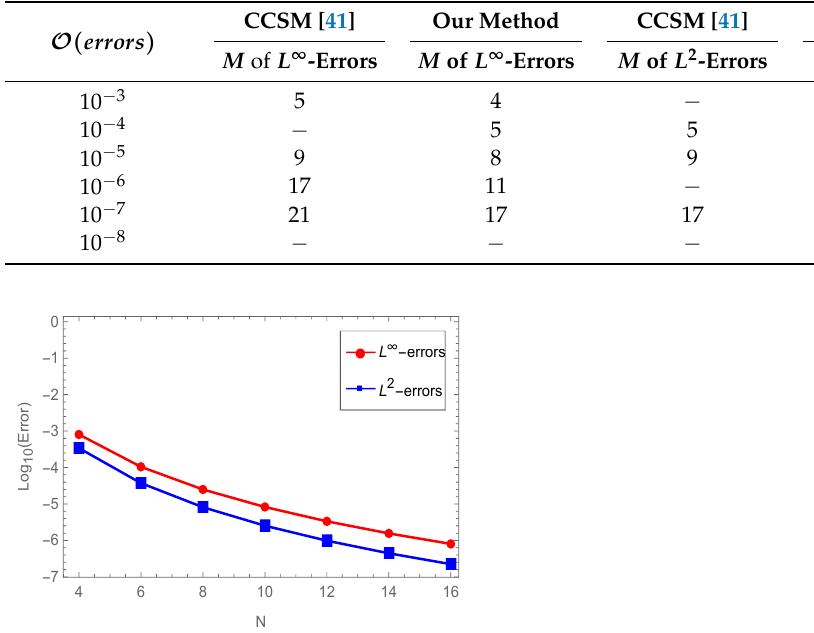
Table 8. Comparison of L ∞ - and L 2 -errors of our algorithm for υ 1 = 0.5 and b = 0 with the CCSM in [41] by the approximate solution of degree M for Example 4.